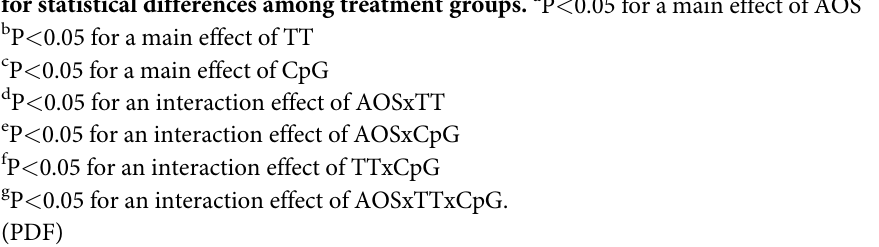
S1 Table. Average V-, D-, and J-gene segment, constant region usage, and CDR3 AA